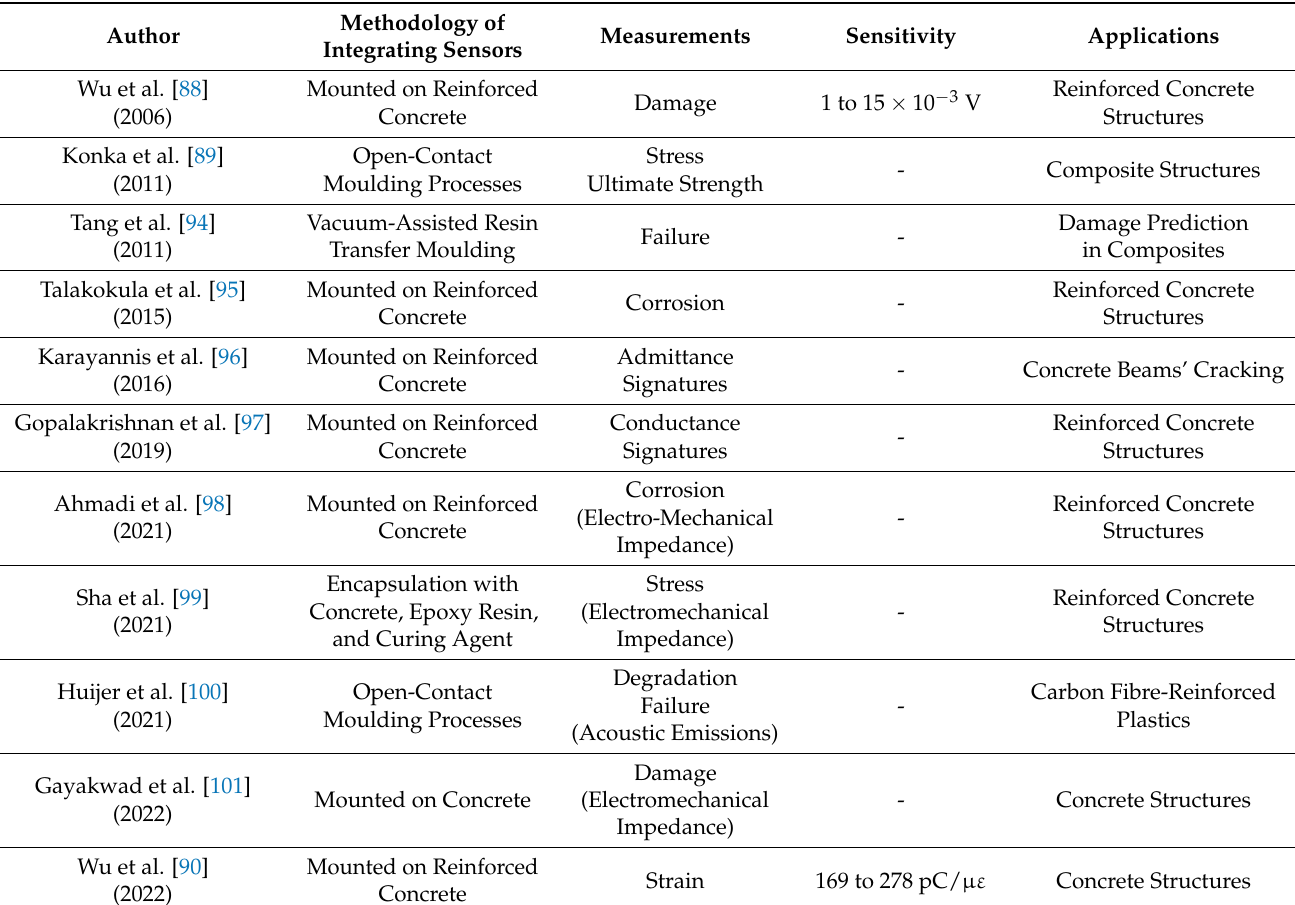
Table 5. Overview of applications and methodology of integrating Lead Zirconate Titanate (PZT) piezoelectric sensors into composite structural